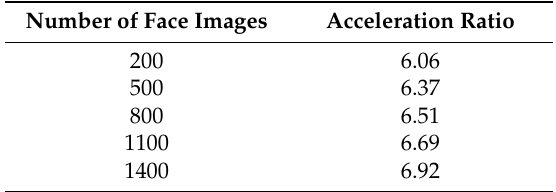
Table 4. Acceleration ratios of central processing unit (CPU) and graphics processing unit (GPU) using the LFW face database.